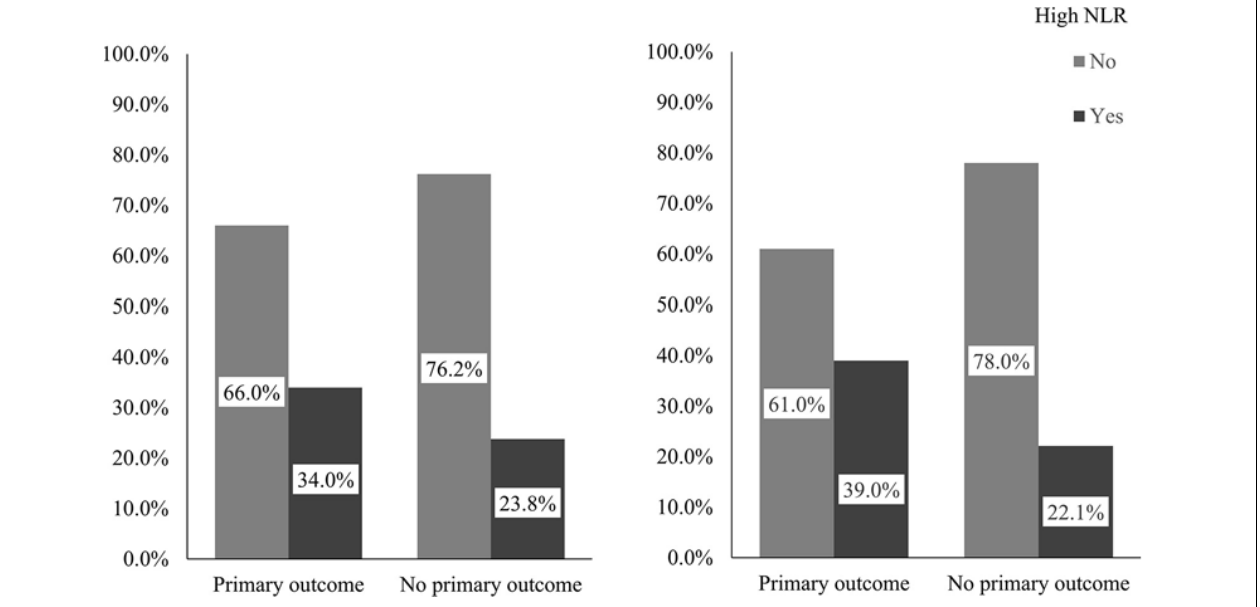
FIGURE 2 | Percentages of patients with high NLR in those with or without a primary outcome. The left panel demonstrates percentages of patients with high NLR in those with or without a primary outcome in the overall cohort and the right in older patients. The primary outcome was a composite outcome of stroke (either ischemic or hemorrhagic), acute coronary syndrome and vascular death within 1 year. NLR indicates neutrophil to lymphocyte